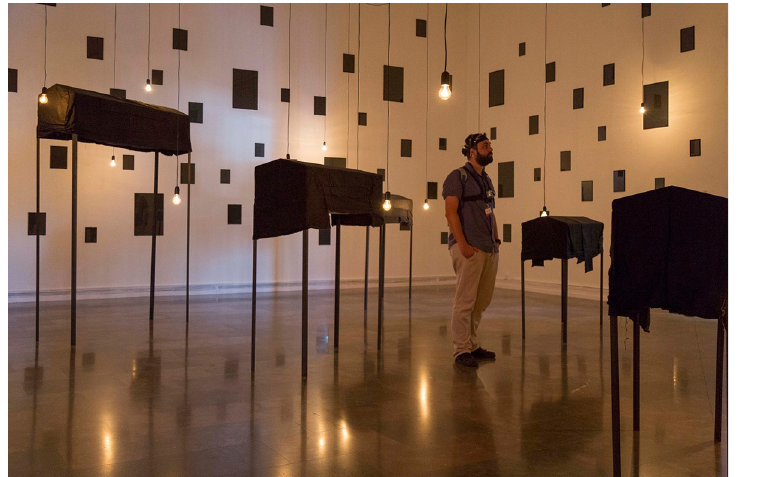
Fig 2. Example of the experimental set-up in the real